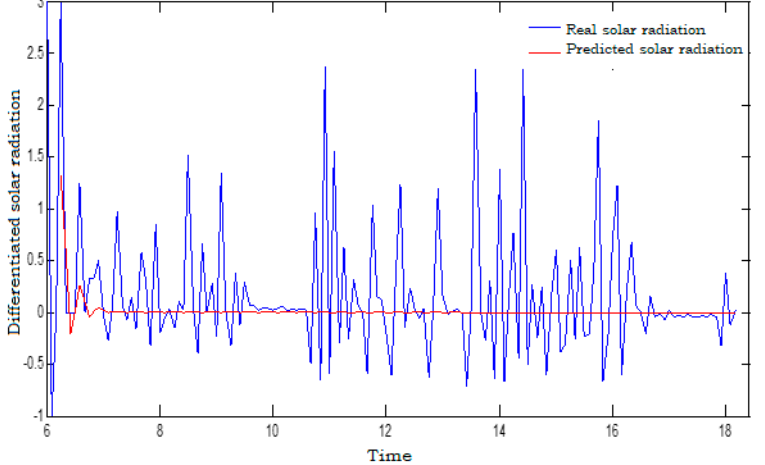
Figure 12. Prediction of solar radiation by the ARMA (3,3) model for a summer day.